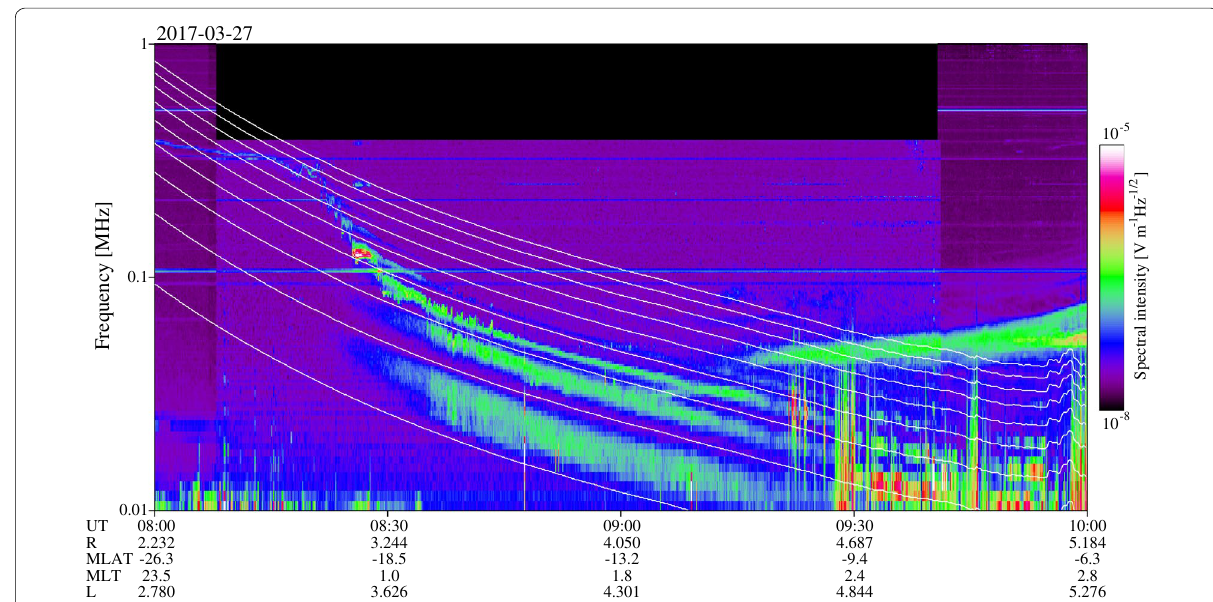
Fig. 3 Expanded spectrogram of ESCH waves. The harmonics of the electron cyclotron frequencies are indicated by white